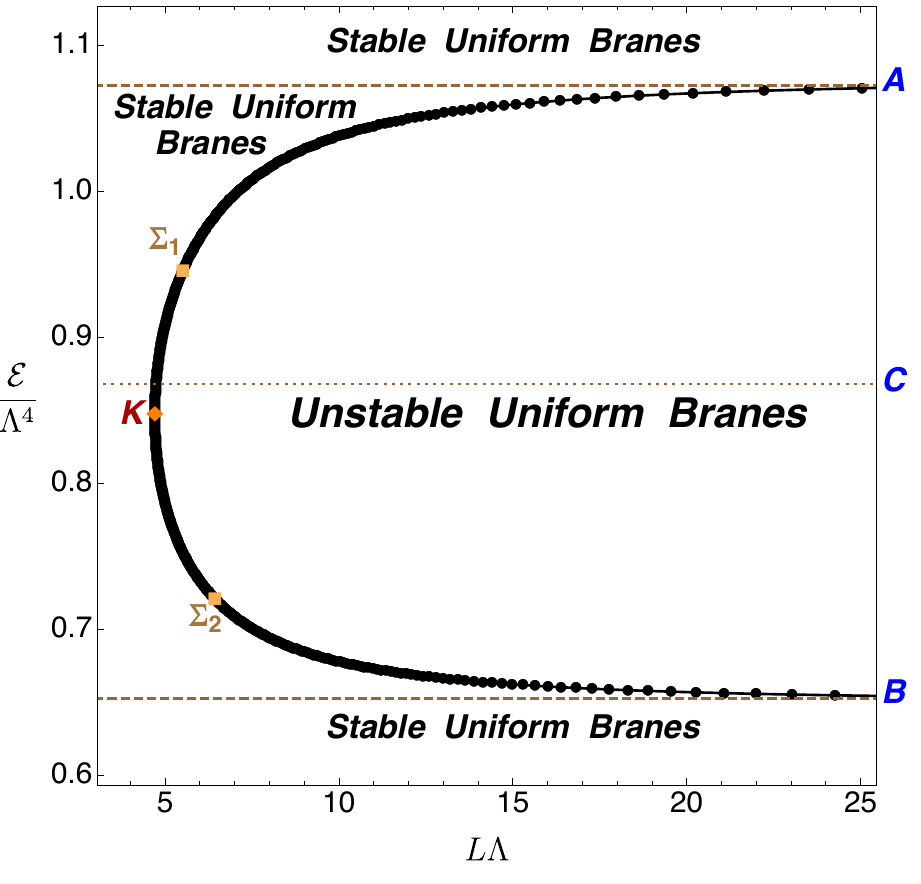
Figure 8 . Stability diagram for uniform nonconformal branes. The interpretation of the two yellow square points Σ 1 and Σ 2 will be given when discussing figure 10. For reference, ( ˆ T, ˆ L , ˆ E ) Σ ’ (0 . 390817 , 5 . 618133 , 0 . 950579) and ( ˆ T, ˆ L GL 1